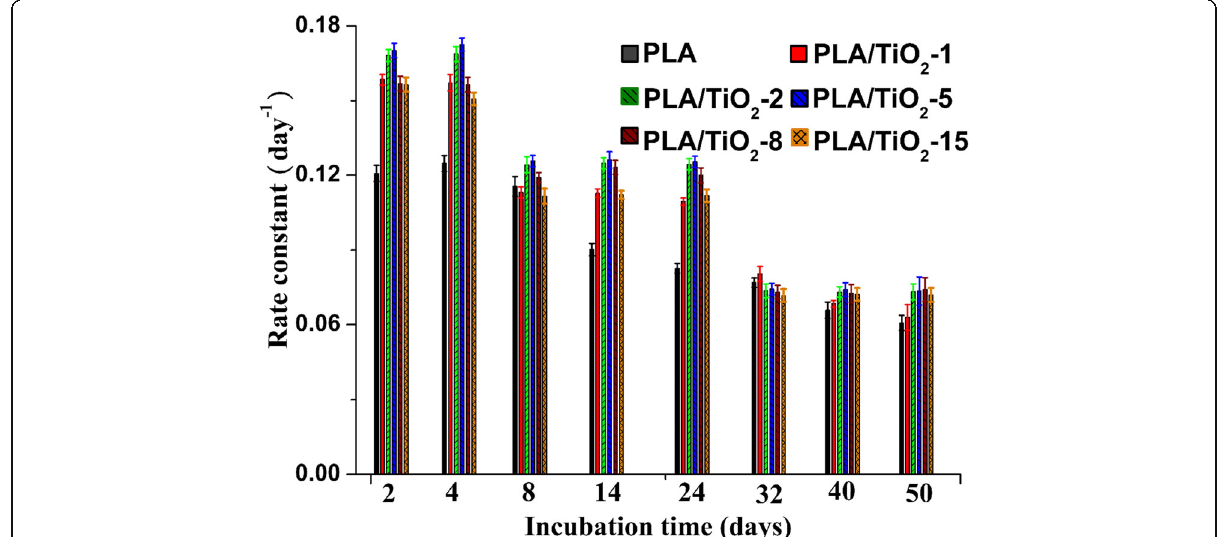
Fig. 7 Biodegradation rate versus incubation time for pure PLA and PLA/TiO 2